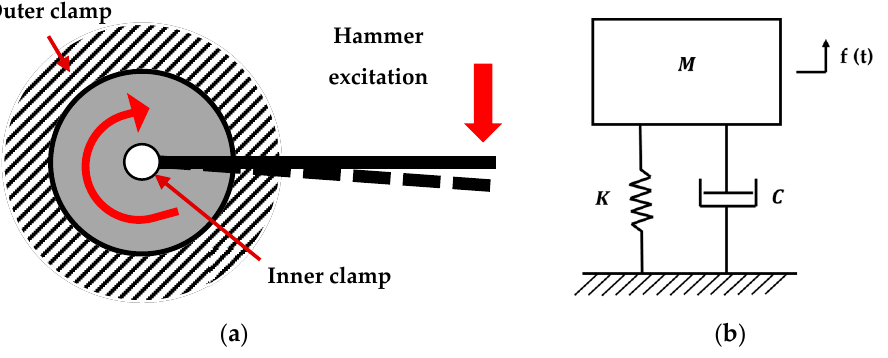
Figure 3. ( a ) Schematic diagrams of the testing setup: the moment arm behaves as a beam clamped on a rotational compliance; ( b ) an equivalent damped single degree of freedom system, where M , K , and C , represent the lumped mass, stiffness, and damping, respectively, of the depicted system.